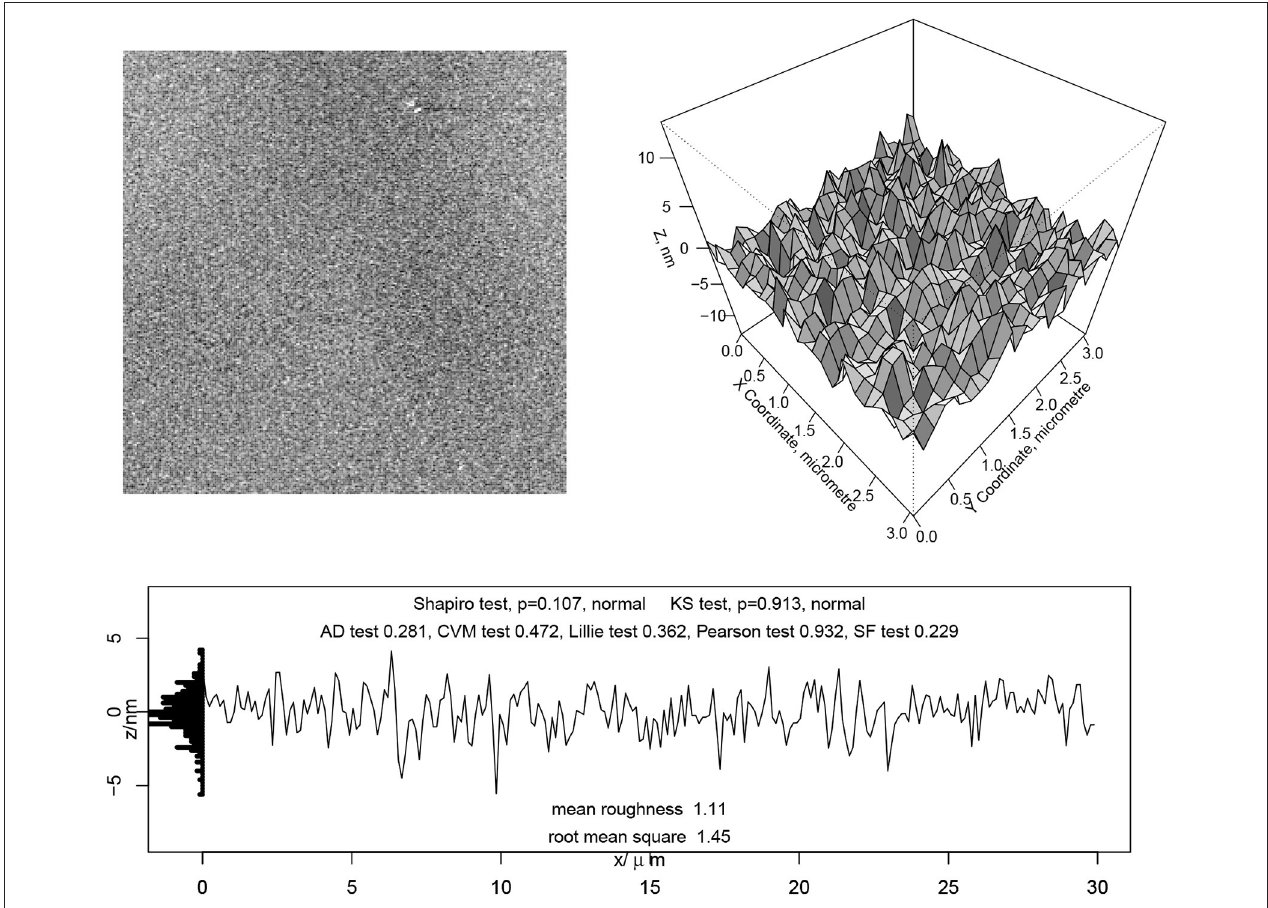
FIGURE 5 | The AFM scan of the a-C (bias) sample after profilometer measurements. (Left) full measured patch 30 x 30 µ m . (Right) extracted small region 3 x 3 µ m . (Bottom) A typical profile with normality tests and two descriptive statistics (values are in nm): the root mean square (rms) and the mean